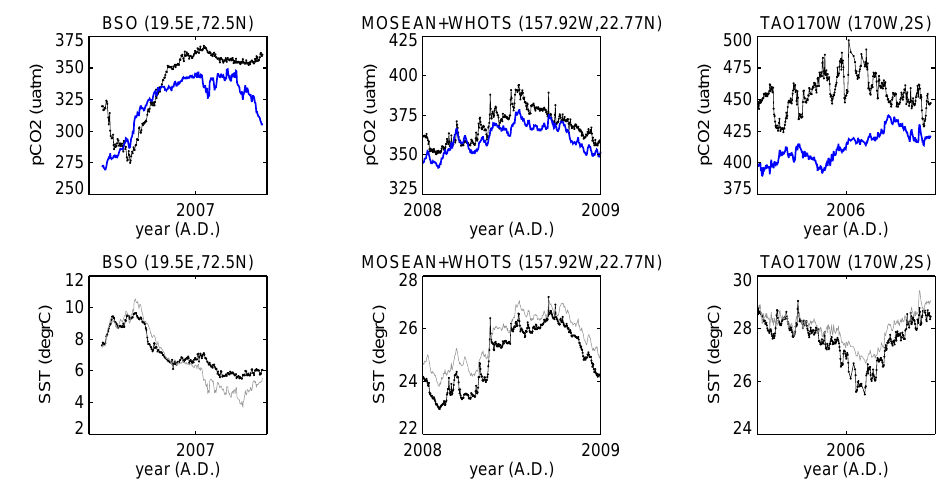
Fig. 10. Top: time series of surface-ocean p CO 2 (µatm) at independent mooring sites (not part of SOCATv1.5): Barents Sea Opening (72.5 ◦ N, 19.5 ◦ E, Arthun et al., 2012), combined MOSEAN and WHOTS moorings (22.77 ◦ N, 157.92 ◦ W, Sabine et al., 2010), and from the TAO array (2 ◦ S, 170 ◦ W, Sabine et al., 2010). Comparison between the measurements (black dots) and the p CO 2 field estimated by fitting to the SOCAT data (blue). The estimated field has been picked at the times where measurements exist; one year has been selected for each site. Bottom: sea surface temperature measured simultaneously with p CO 2 (black dots) compared to our SST driving field at this pixel (light grey).